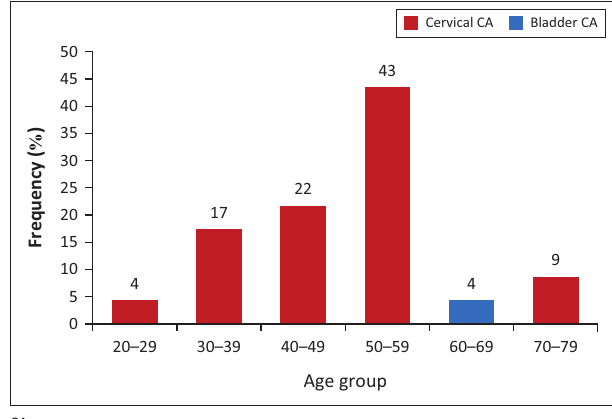
FIGURE 2: Frequency distribution of stage II